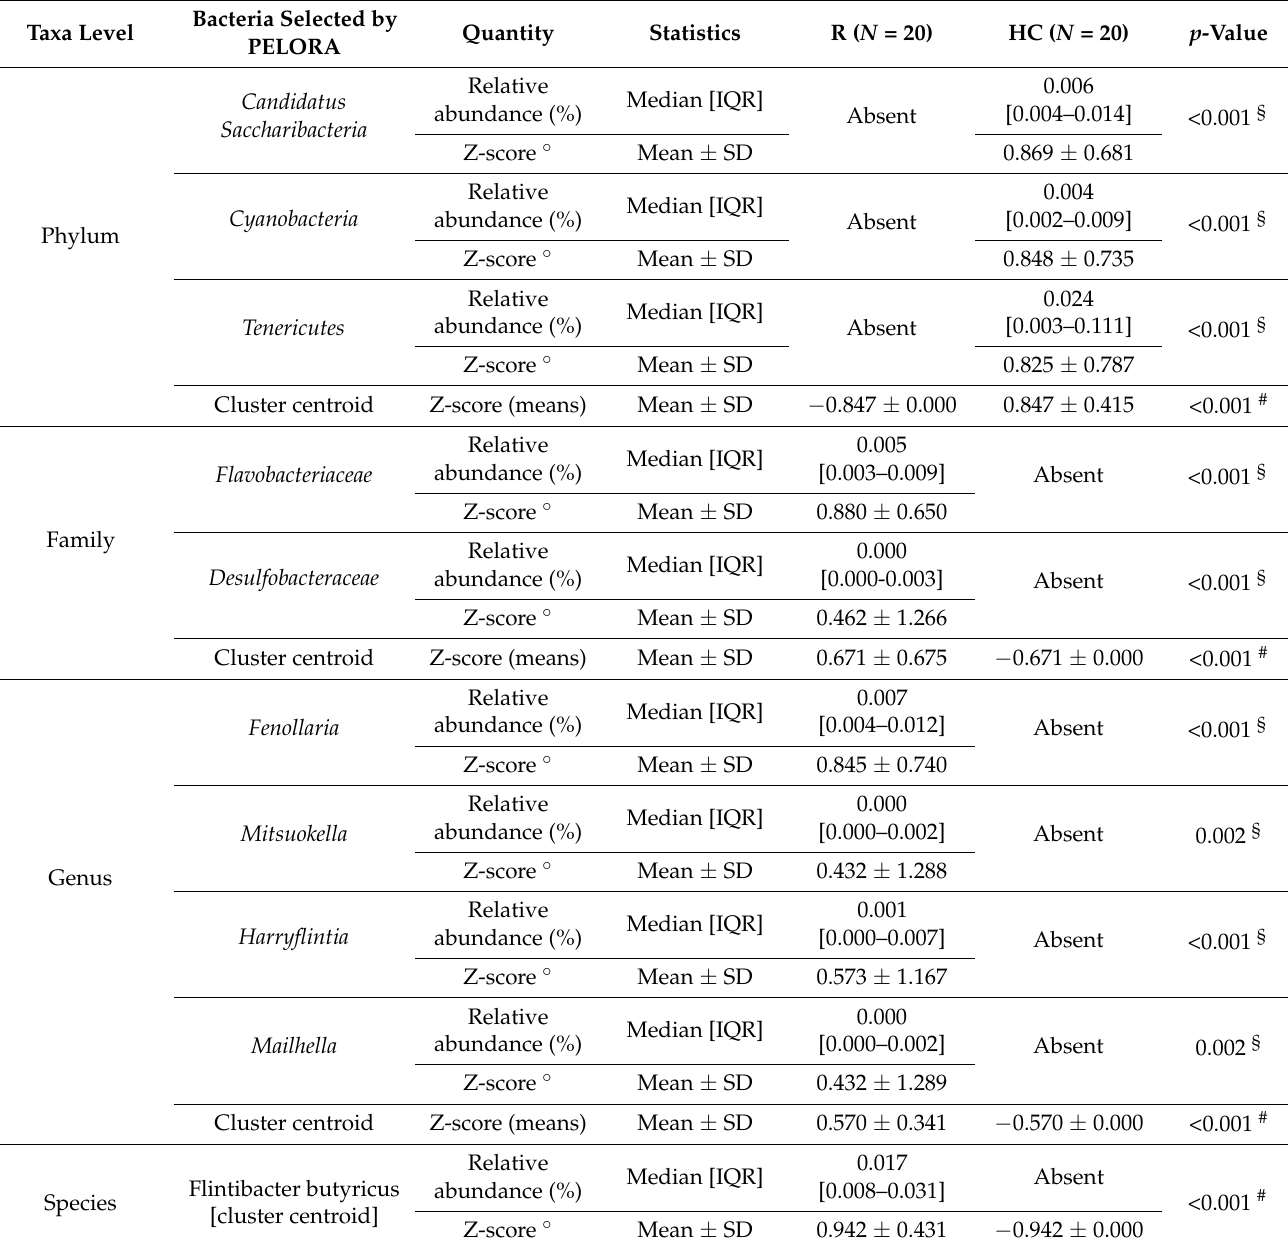
Table 4. Results from Penalized Logistic Regression Analysis (PELORA) algorithm which identifies panels of bacterial populations that best discriminate R patients with SCZ from